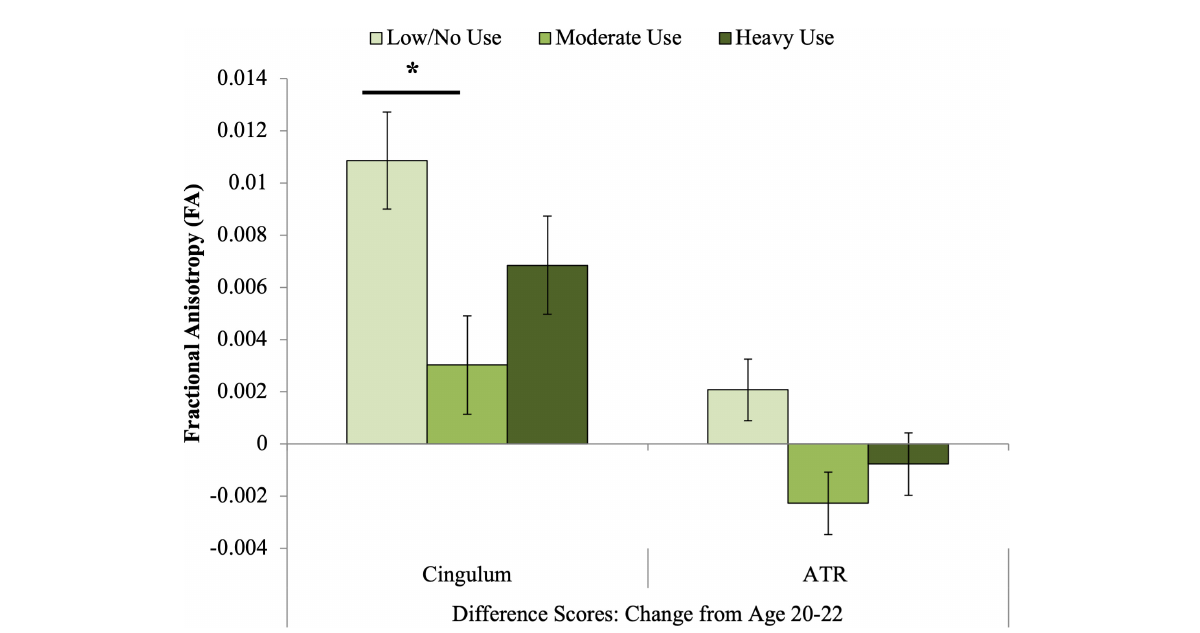
FIGURE2 Associations between cannabis exposure and longitudinal FA development from 20 to 22. A significant association was observed between extended cannabis exposure and change in cingulum FA across these 2 years. Bonferroni-corrected post hoc tests revealed that the difference between the minimal use and moderate extended cannabis use groups was statistically significant for change in cingulum FA ( p corrected < 0.05). *indicates significant Bonferroni-corrected post hoc pairwise